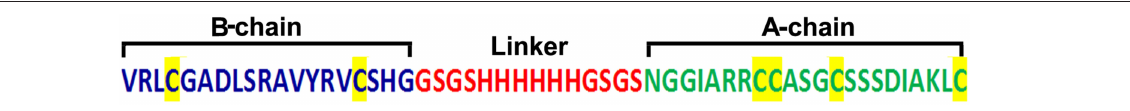
FIGURE 1 | Holothuria scabra RGP protein encoded within the vector construct. A-Chain (green), B-chain (Blue) and histidine linker (red) regions are shown. Yellow highlight backgrounds indicate conserved cysteine